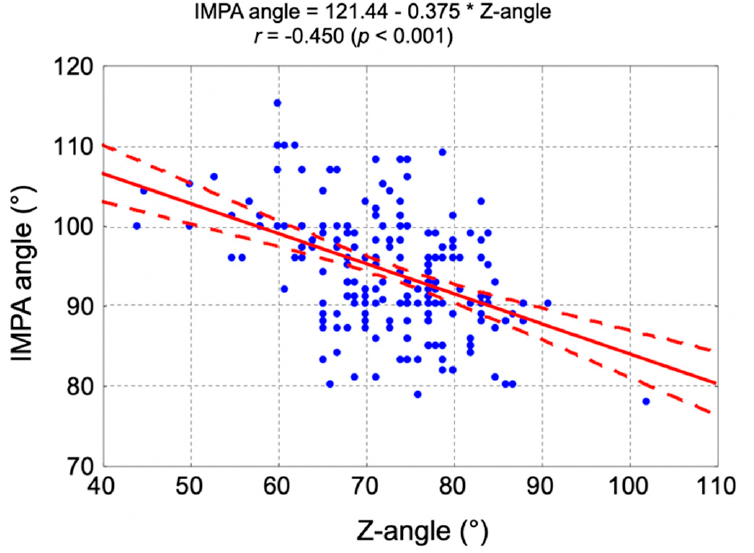
Figure 7. The correlation diagram between the Z-angle and IMPA angle, correlation coefficient, and regression straight-line equation. IMPA—incisor mandibular plane angle. Receiver operating characteristic (ROC) curves were used to find the most accurate cephalometric parameters describing patients with a convex profile. Table 9 presents the results of the analysis of the ROC